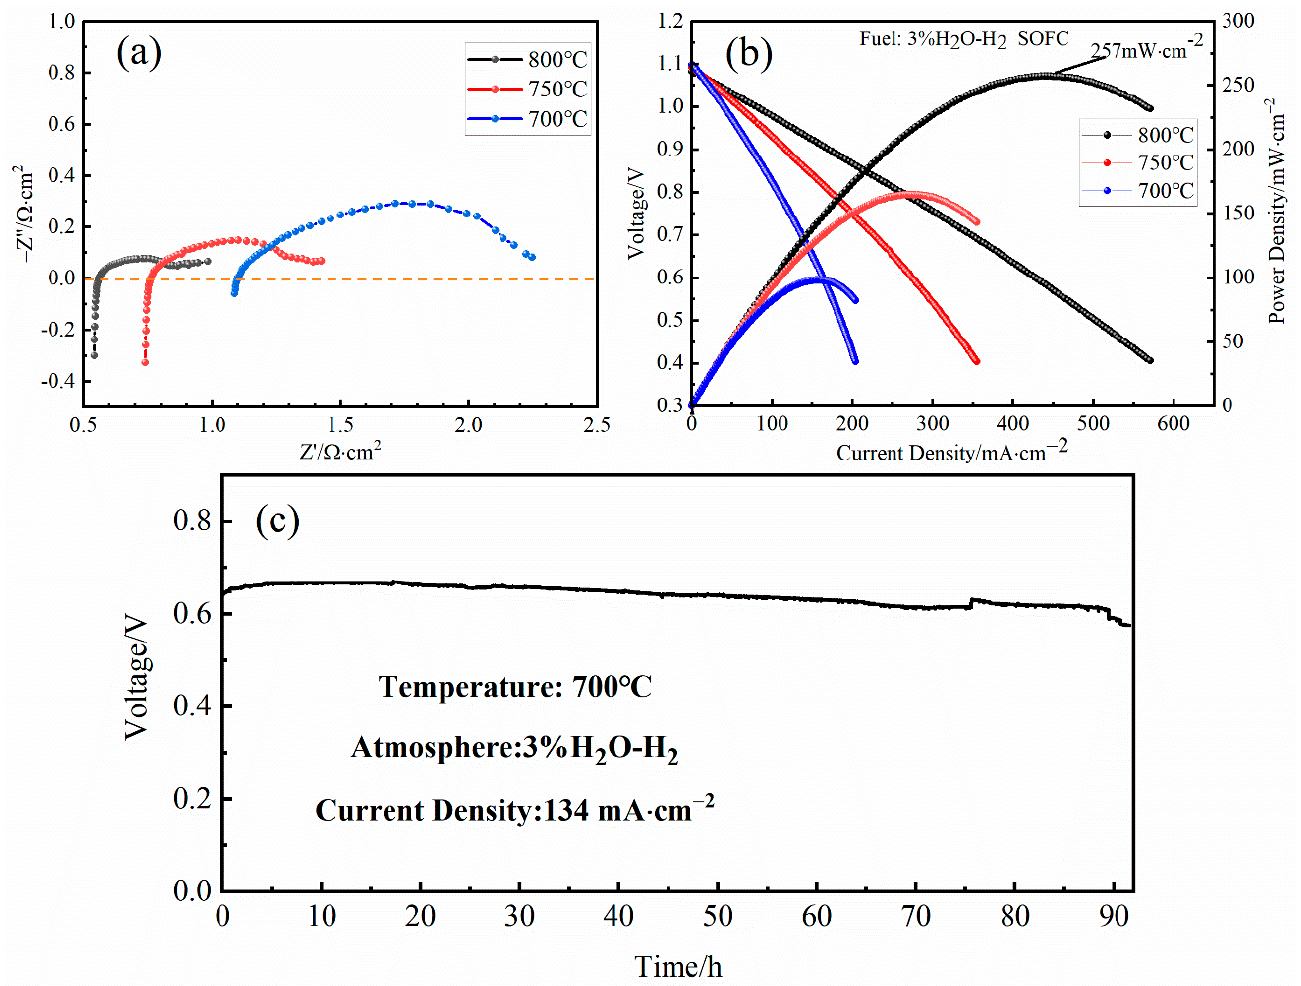
Figure 7. Impedance spectra under open-circuit conditions ( a ) and I − V and I − P curves of humidified H 2 ( b ), for LSGM electrolyte-supported SOCs with nanofiber-based SFM symmetrical electrode measured from 800 °C to 700 °C and 90 h duration test in the SOFC working mode ( c ).